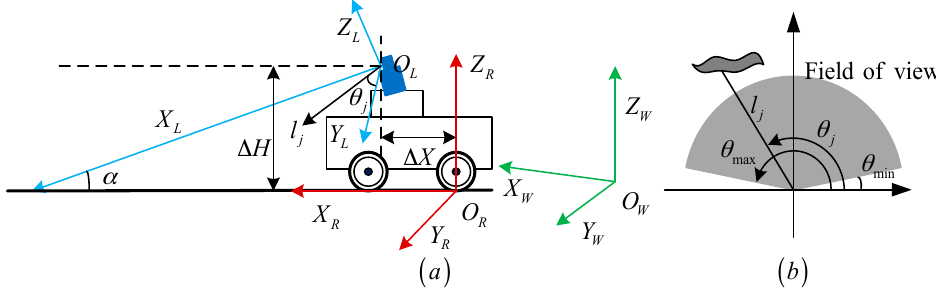
Figure 1. Definitions of the system coordinates. ( a ) Coordinate system; ( b ) Laser polar coordinate system.